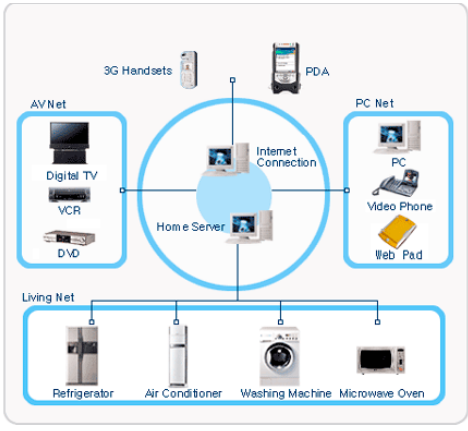
Figure 1. Network configuration for ECMA-392.